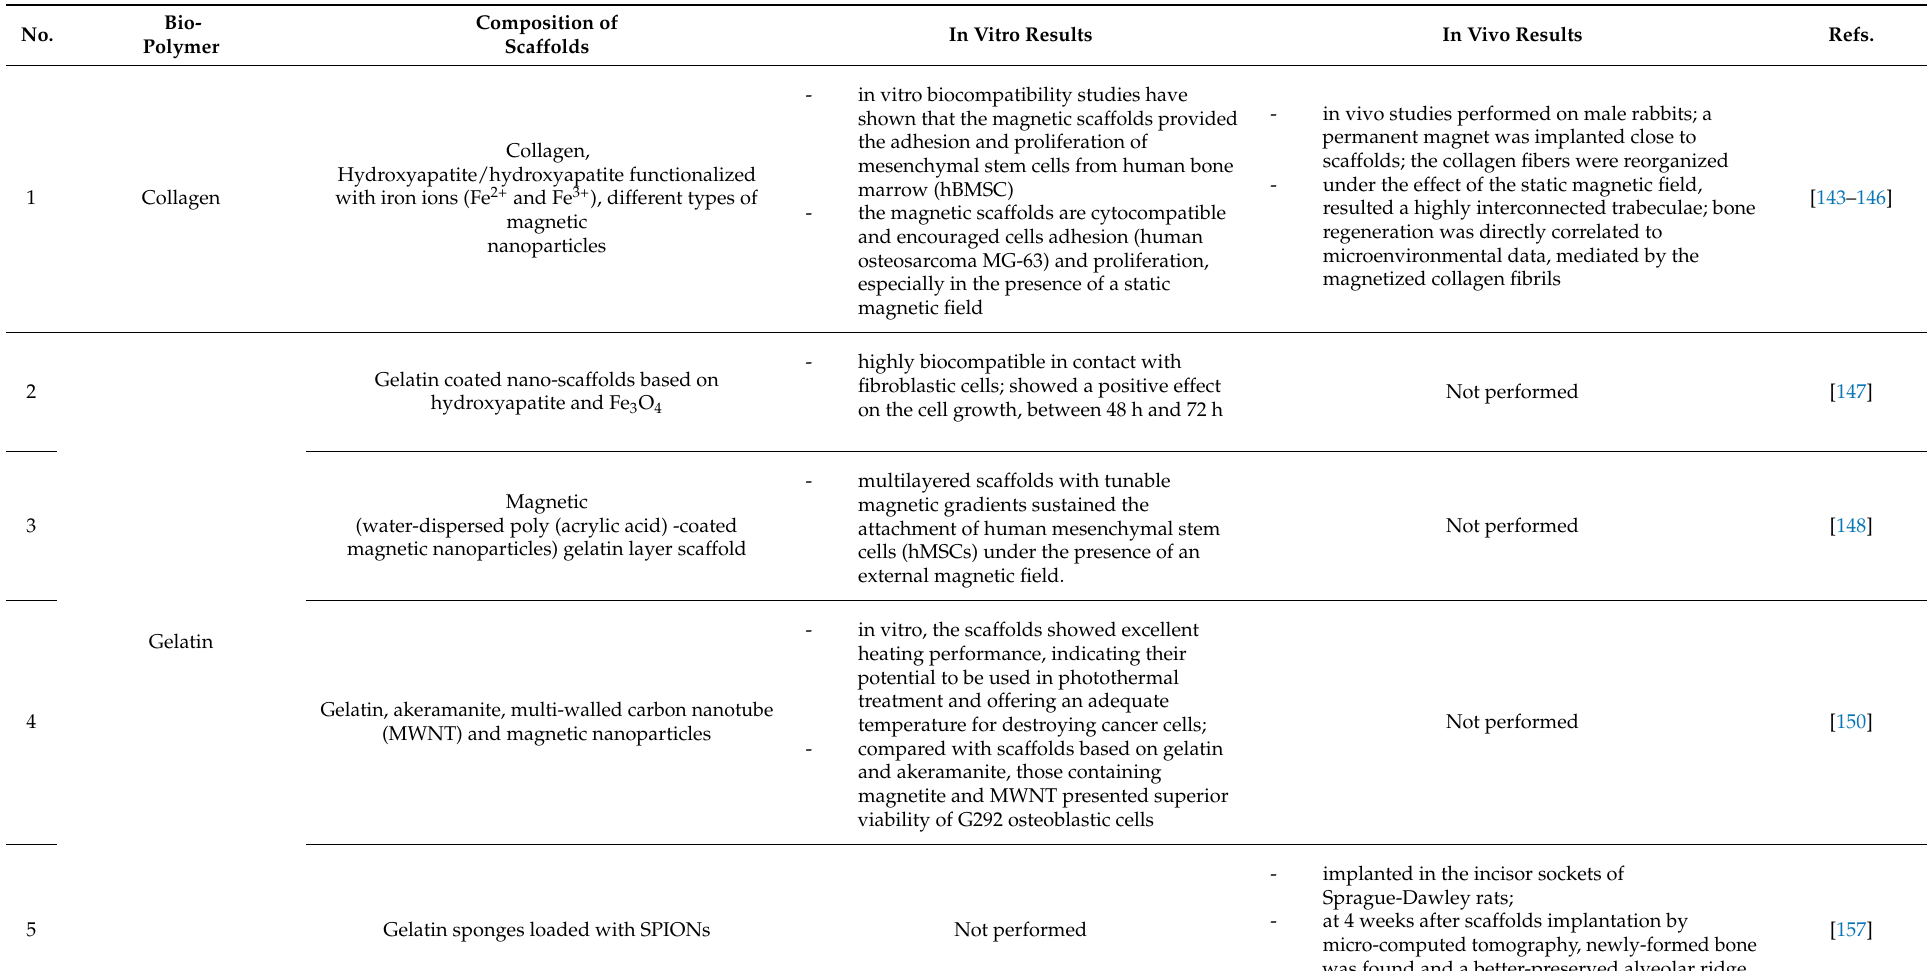
Table 2. In vitro and in vivo results focused on magnetic scaffolds with